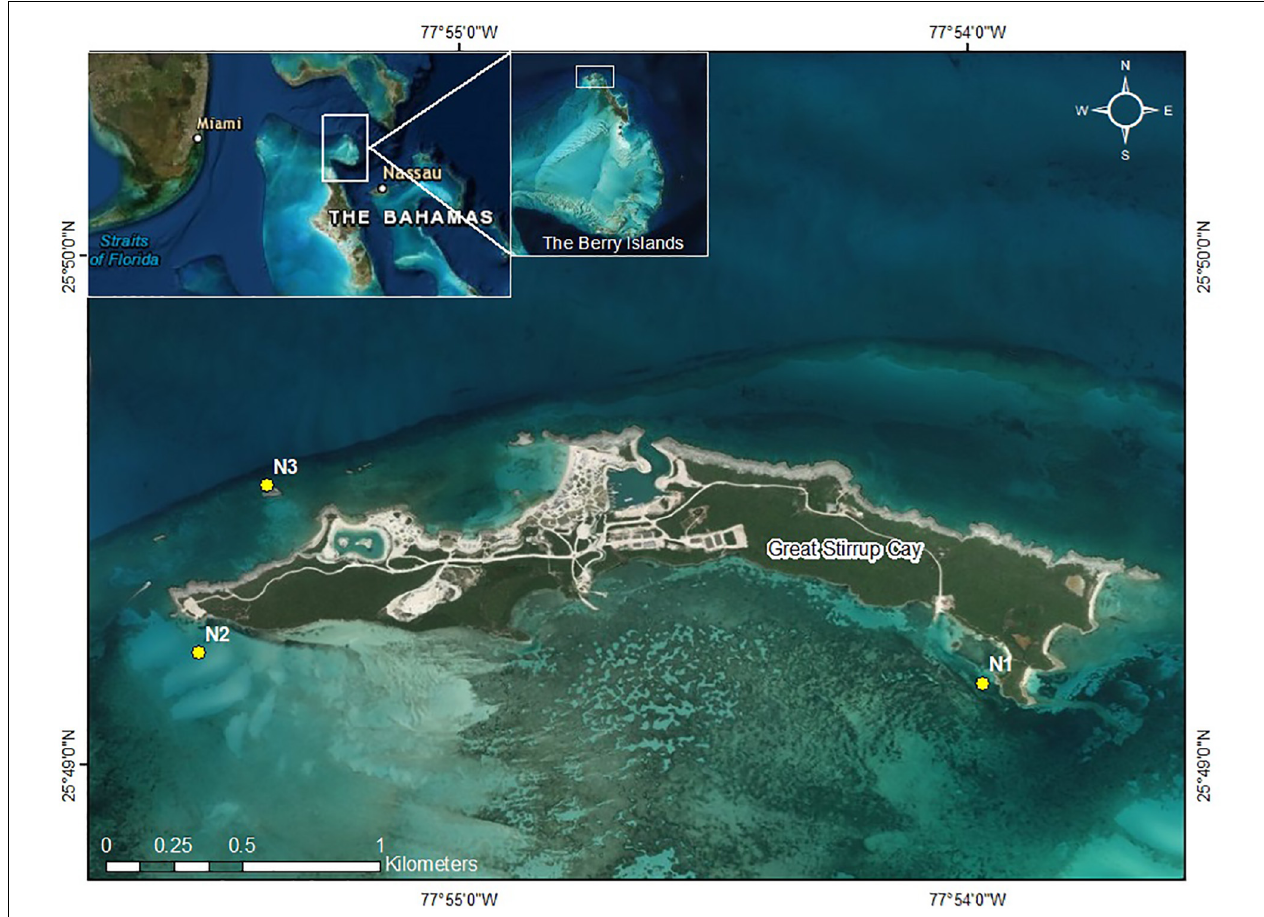
FIGURE 1 | Great Stirrup Cay (GSC). Yellow dotes indicate nursery sites. Inset : The Berry Islands, The Bahamas, in relation to Florida and the greater